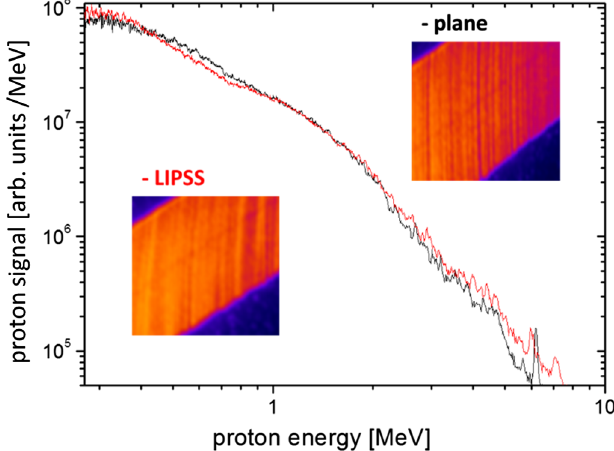
FIG. 4. Appearance of density modulation in fast proton bunches produced with HC laser pulses irradiating plane or LIPSS Ti foils (parameter cf. the text). The noncalibrated proton signal is evaluated with energy binning. Inset: Contrast-enhanced parts of the recorded proton